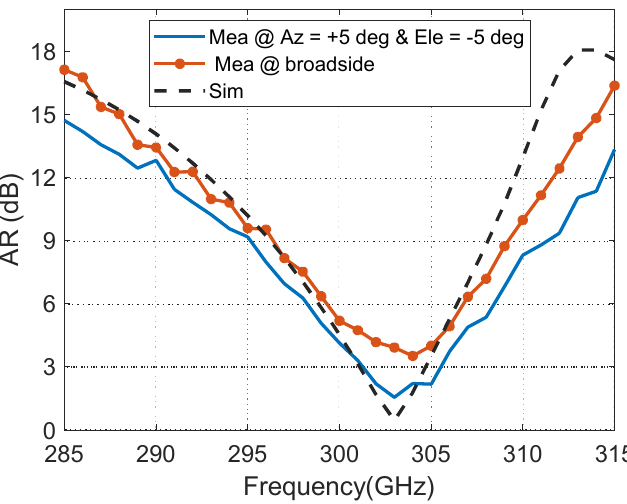
Figure 6. Measured and simulated axial ratio (AR) of the proposed antenna.